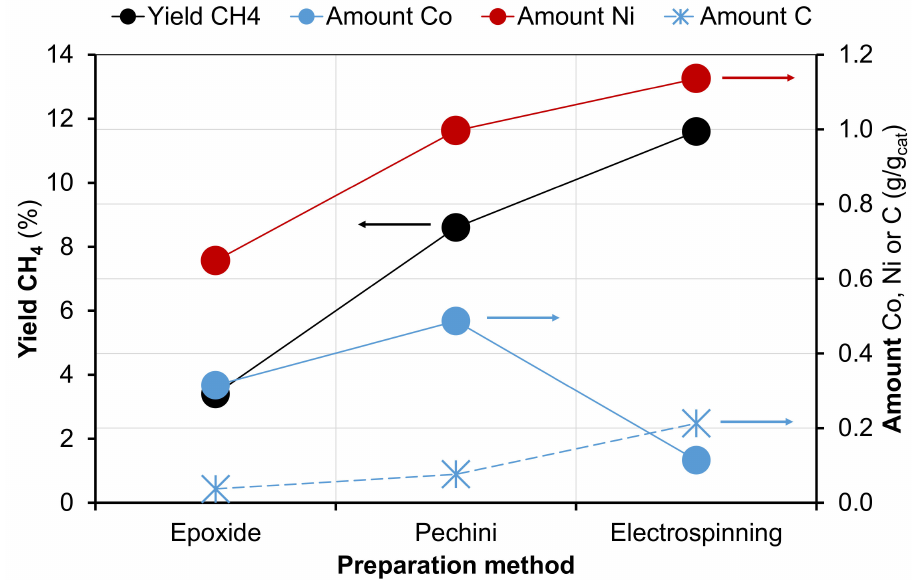
Figure 9. Correlation between catalytic activity at 10 bar/300 ◦ C and amounts of Co, Ni and C on samples prepared by different methods (Epoxide addition and Pechini methods and Electrospin- ning